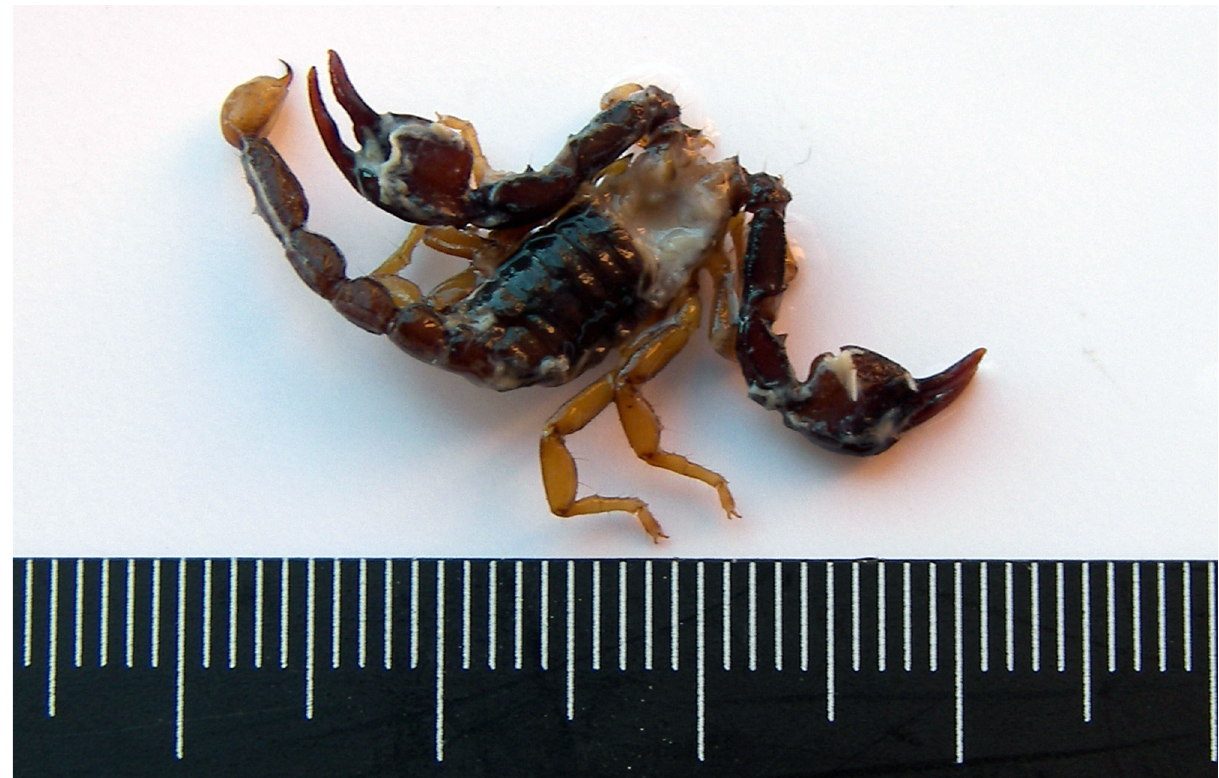
Figure 1 . Euscorpius flavicaudis that stung the subject of the present report (photo by M.